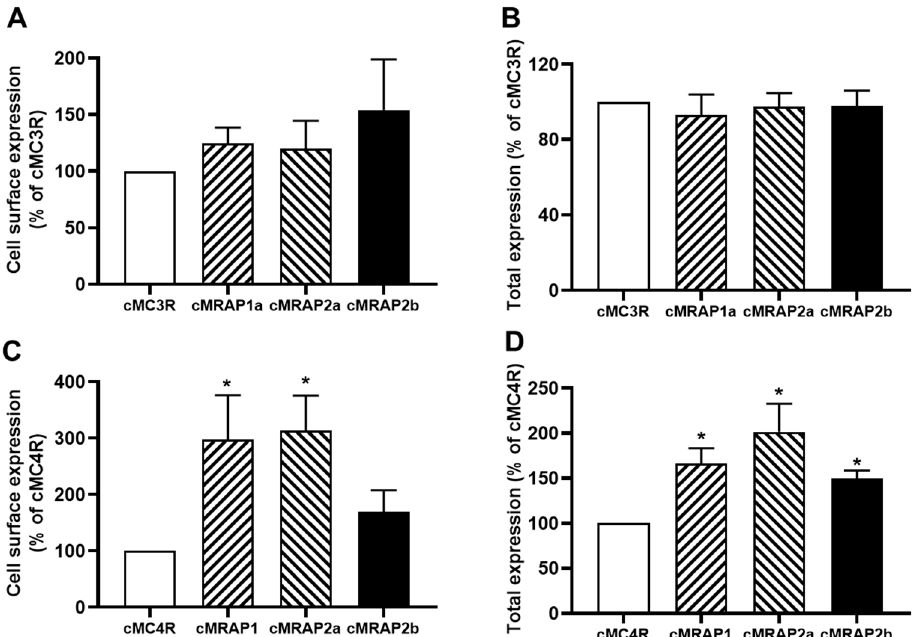
Figure 6. Regulation of cMC3R ( A , B ) and cMC4R ( C , D ) expression by MRAPs. Cell surface and total expression of cMC3R and MC4R was measured by flow cytometry. HEK293T cells were co-transfected with cMC3R or cMC4R and cMRAPs (1:5). Fluorescence in cells transfected with empty vector pcDNA3.1 was used for background staining. The results were calculated as % of 1:0 group. Each data point represented the mean ± SEM (n = 3–4). * Indicates significantly different from 1:0 group ( p < 0.05) (one-way ANOVA followed by Tukey test).